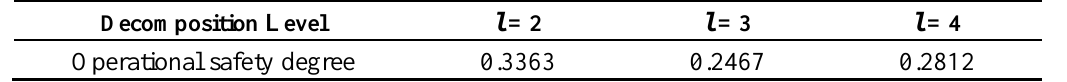
Table 1. The operational safety degree before maintenance from sensor-dependent vibration